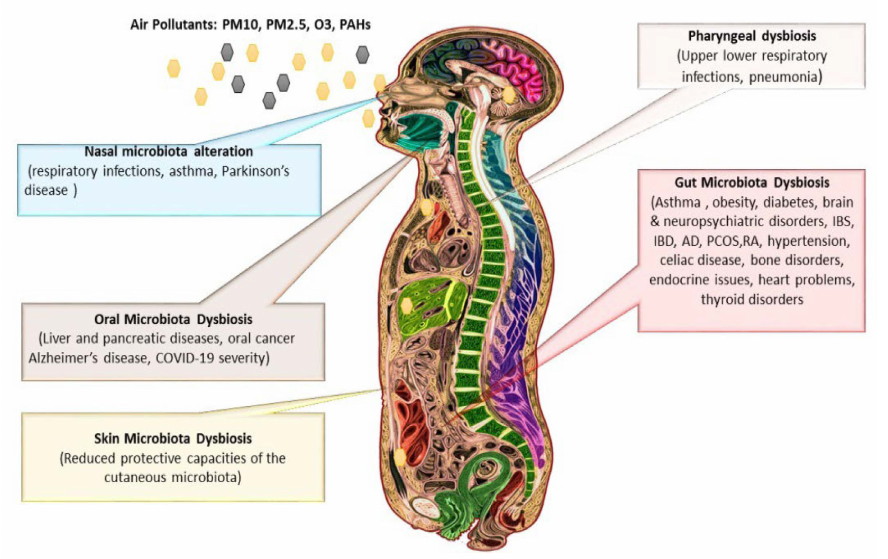
Figure 3. Air pollution-associated microbial dysbiosis in different organs and potentially associated health